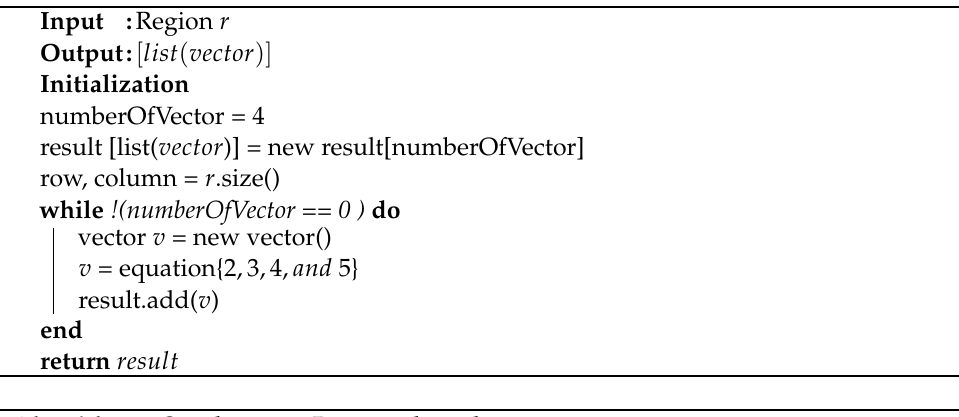
Algorithm 3: HVR decomposition algorithm